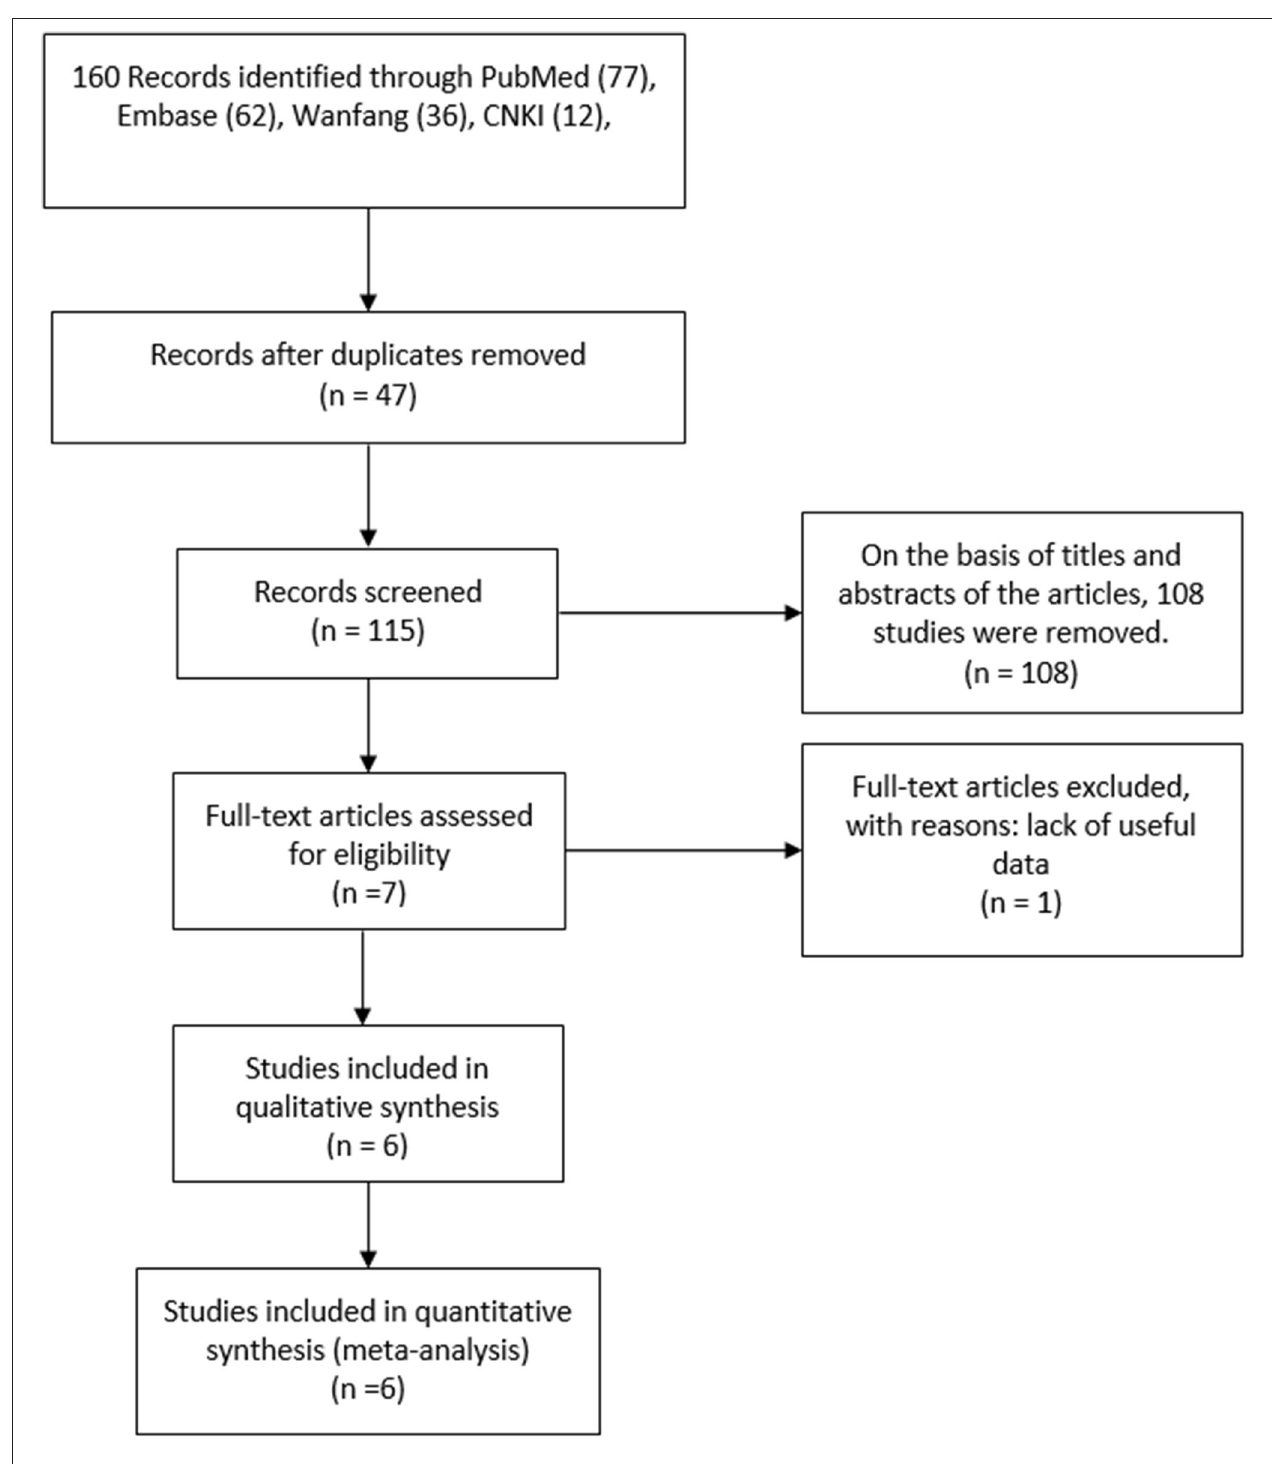
FIGURE 1 | Flowchart of study inclusion.